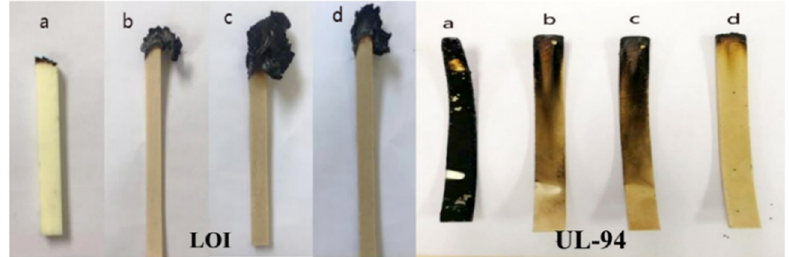
Figure 7: Photographs of the samples after LOI and UL - 94 tests ( a: EP, b: EP1, c: EP2, and d: EP3 )